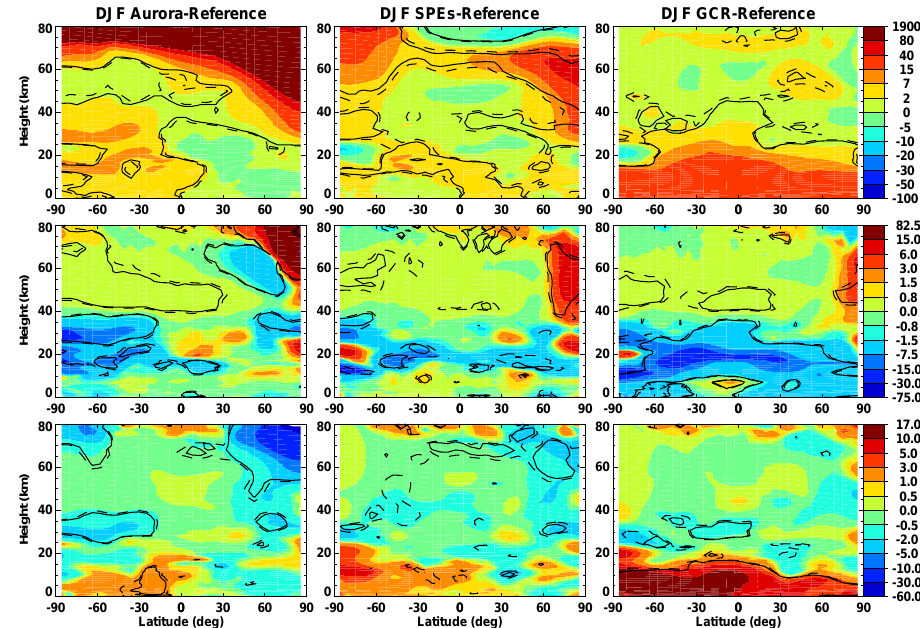
Fig. 5. Run mean, December–February mean NO y (top, %), HO x (middle, %) and O 3 (bottom, %) differences for auroral zone electrons, SPEs and GCR runs compared to the reference run.